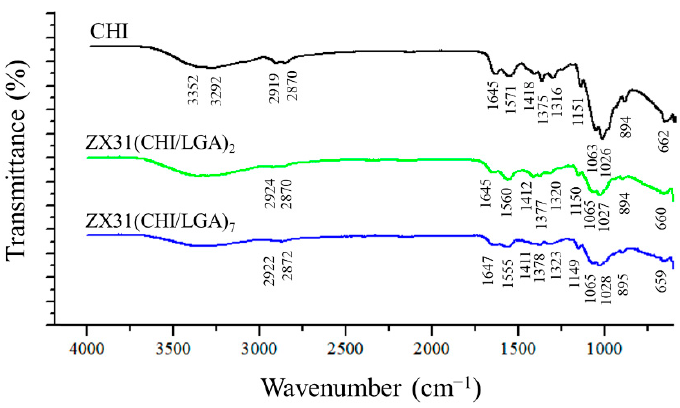
Figure 4. FTIR spectra of pure CHI, ZX31(CHI / LGA) 2 and ZX31(CHI / LGA) 7 specimens.